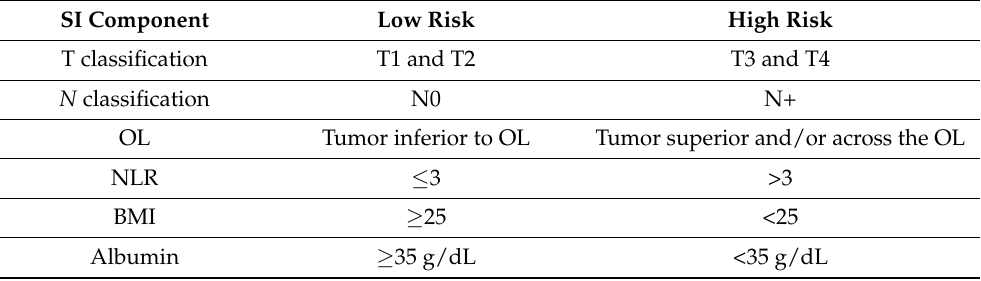
Table 1. Stratification of individual SI components into low- and high-risk groups. For every parameter, a patient can be assigned either 0 (low-risk) or 1 (high-risk), and the SI is the sum of all the individual parameters binary value. SI, survival index; OL, Ohngren’s line; NLR, neutrophil-to- lymphocyte ratio; BMI, body-mass index; g/dL, gram/deciliter. SI Component Low Risk